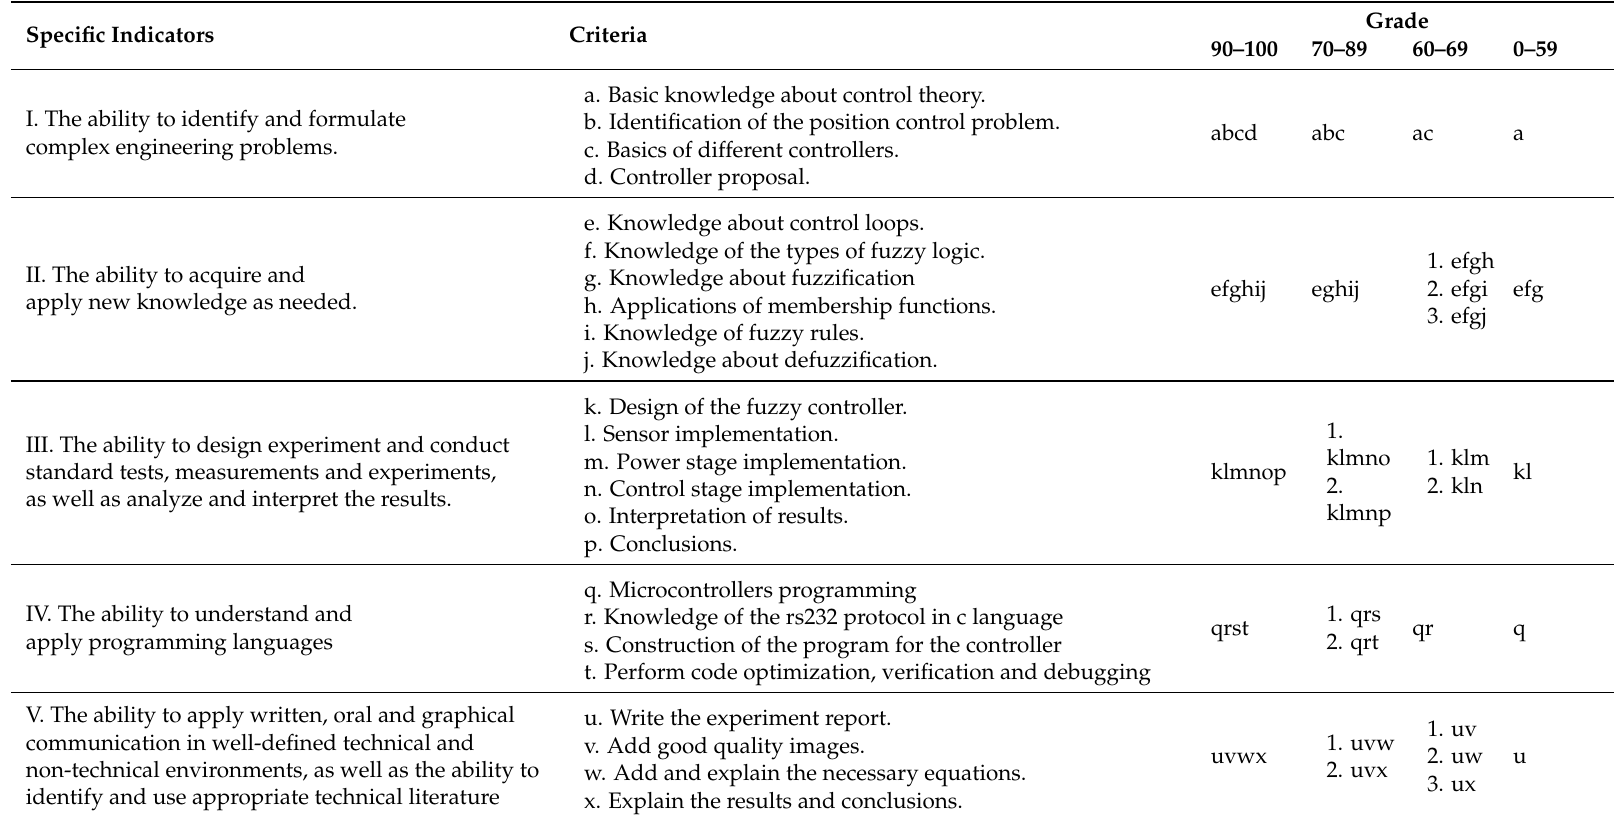
Table 7. Proposed rubric for